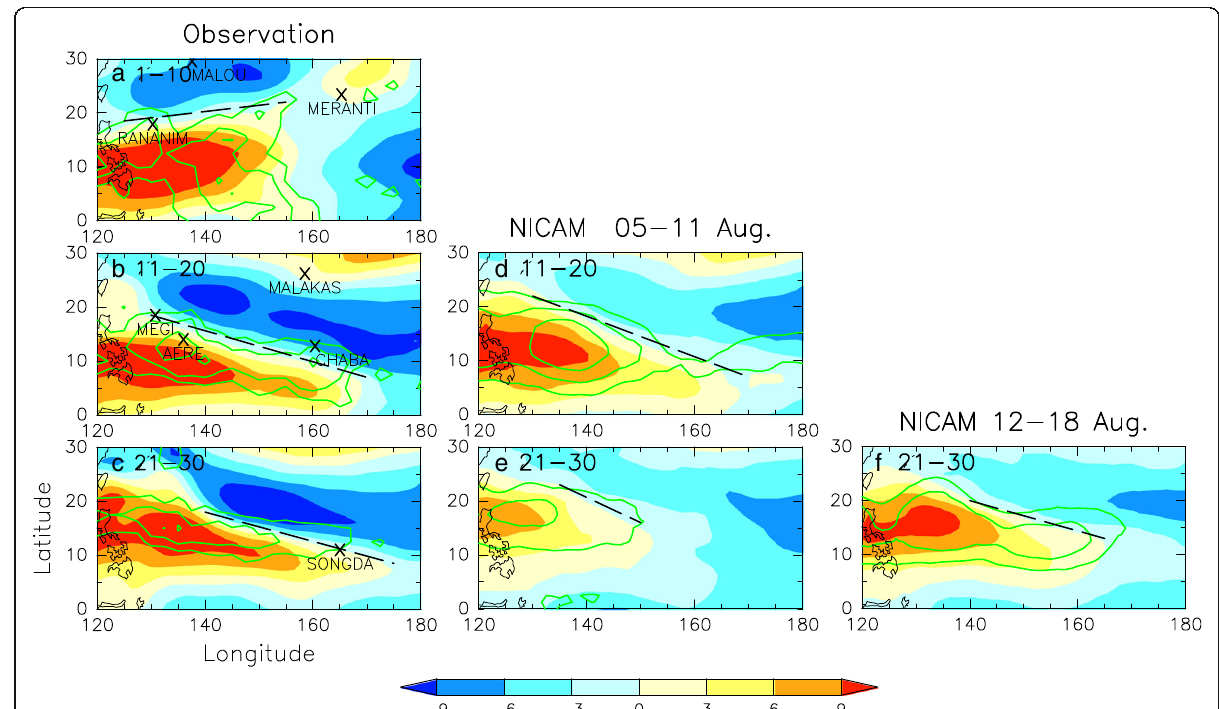
Fig. 9 Comparison of 10-day mean OLR and zonal wind at 850 hPa between observation and simulation. Observed and ensemble mean of 10-day mean OLR ( green contour ) and zonal wind at 850 hPa ( color shading ) averaged during a 1 – 10 August, b , d 11 – 20 August, and c , e , f 21 – 30 August 2004. d , e show NICAM simulation initialized from 5 to 11 August; f shows 12 – 18 August. a Black crosses indicate the locations of tropical cyclogenesis. OLR values less than 200 W m − 2 are shown with contour intervals of 20 W m − 2 . Broken lines depict the shear line. After Fig. 1 of Nakano et al. (2015)